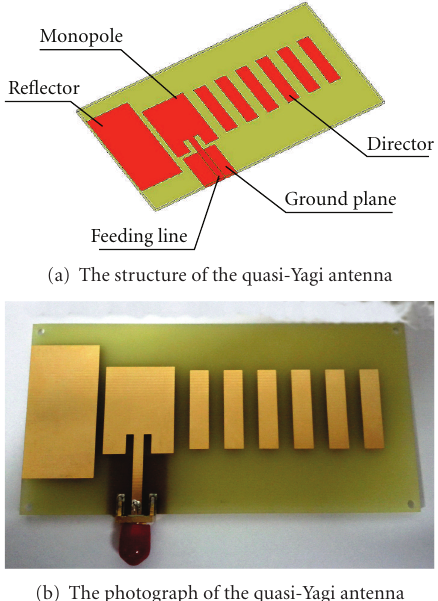
Figure 1: Compact broad-band quasi-Yagi